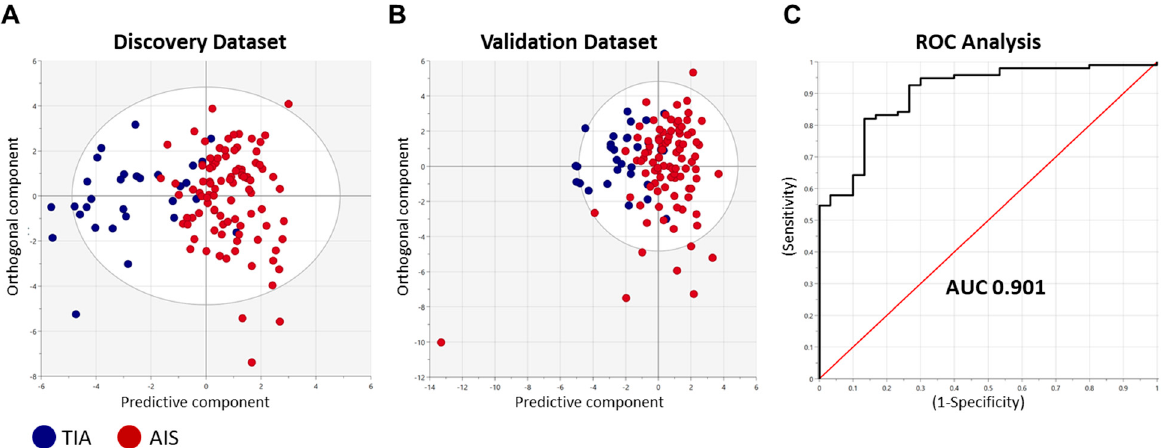
Figure 3. Discriminative performance of the identified miRNA panel to identify AIS patients. Or- thogonal projections to latent structures-discriminant analysis (OPLS-DA) was performed